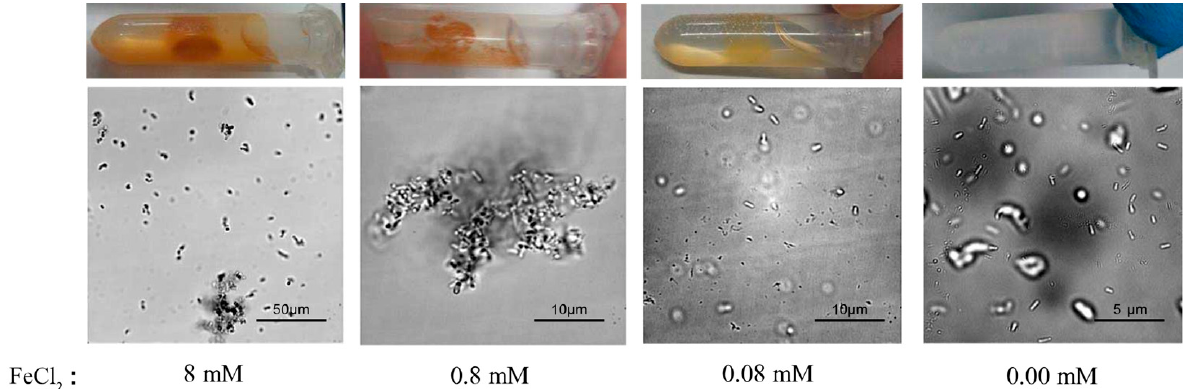
Figure 3. Effect of FeCl 2 concentrations on magnetic MIP. Macroscopic photos and microscopic morphology of precipitates from magnetic MIP with 8-mM, 0.8-mM, 0.08-mM, and 0.00-mM FeCl 2 are shown.